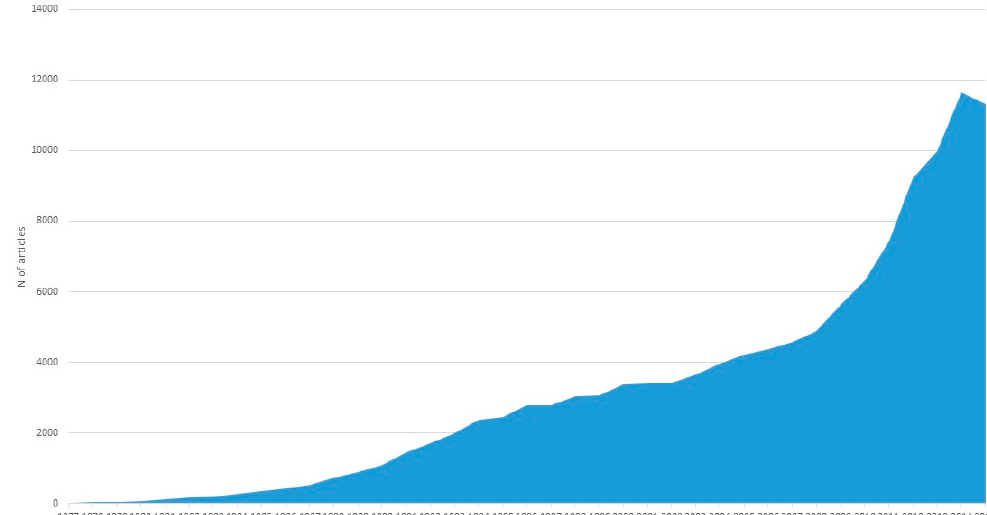
Figure 3. The number of articles published on DNA sequencing annually since 1977.